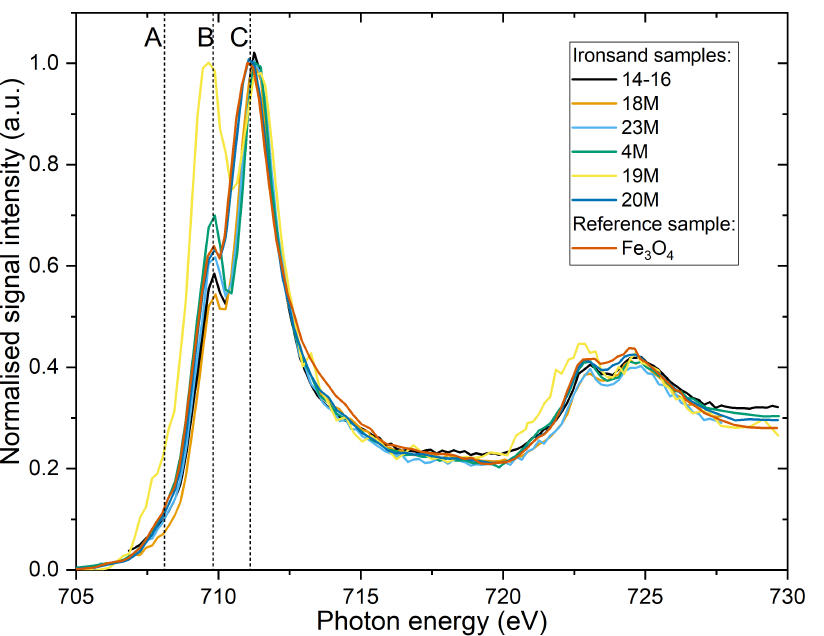
Figure 3. XANES Normalised total electron yield (TEY) Fe L-edge for the different samples and the reference magnetite